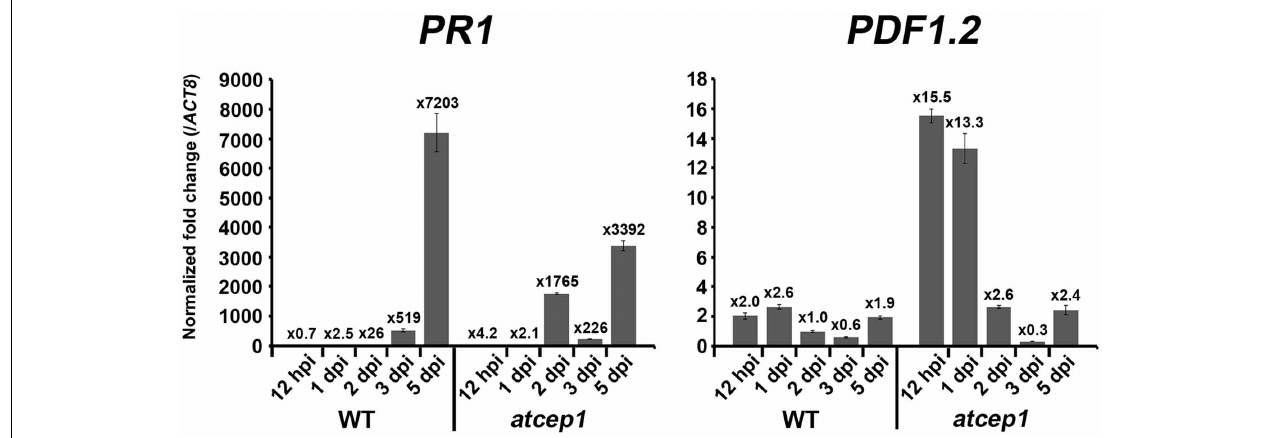
FIGURE 9 | Pathogen-responsive genes expression in atcep1 . Relative gene expression of PR1 and PDF1.2 in wild type and atcep1 plants 12h post mildew inoculation (hpi) and 1, 2, 3, and 5 days post mildew inoculation (dpi). qRT-PCR was performed with PR1 and PDF1.2 gene-specific primers.